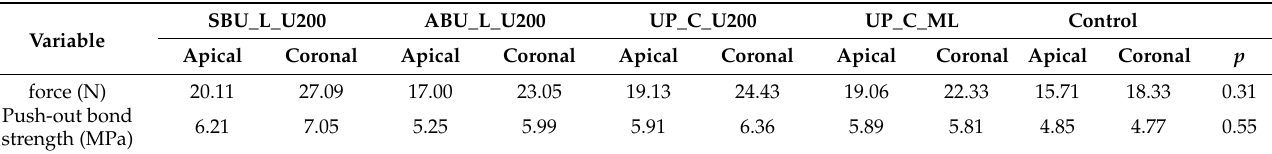
Table 2. Comparison of the debonding force with push-out bond strength of the fiber-reinforced composite posts according to treatment with adhesive primers.